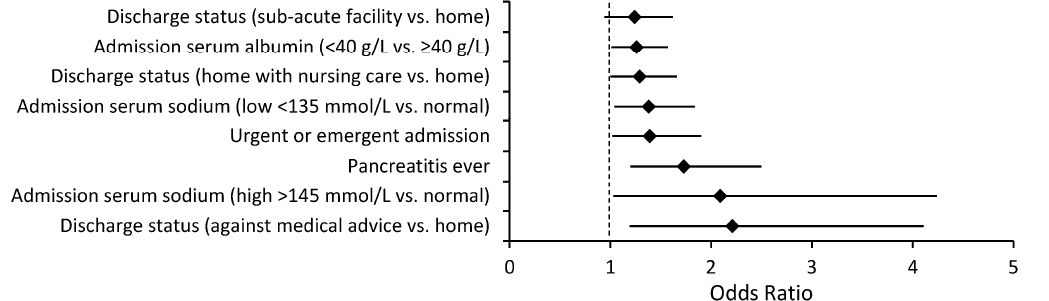
Figure 4. Risk factors for readmission unique to the secondary discharge diagnosis of diabetes, OR (95% CI). (cid:7) = Odds ratio.